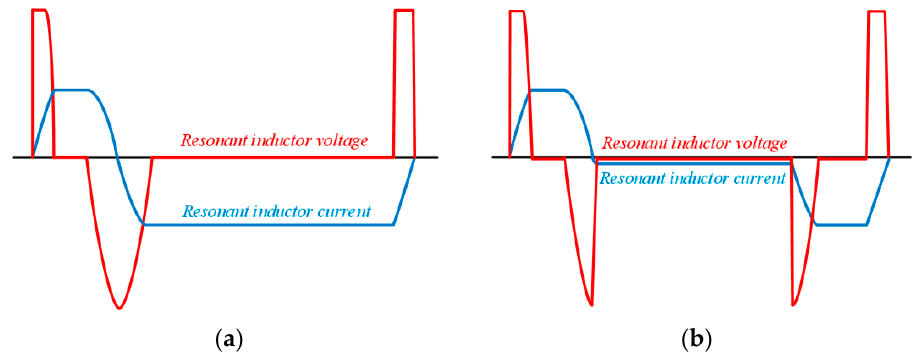
Figure 2. Comparison of resonant inductor current / voltage. ( a ) Conventional converter and ( b ) proposed converter.